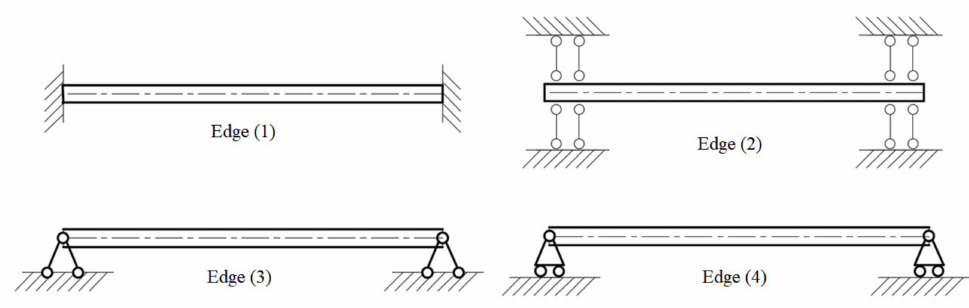
Figure 3. The scheme of four boundary